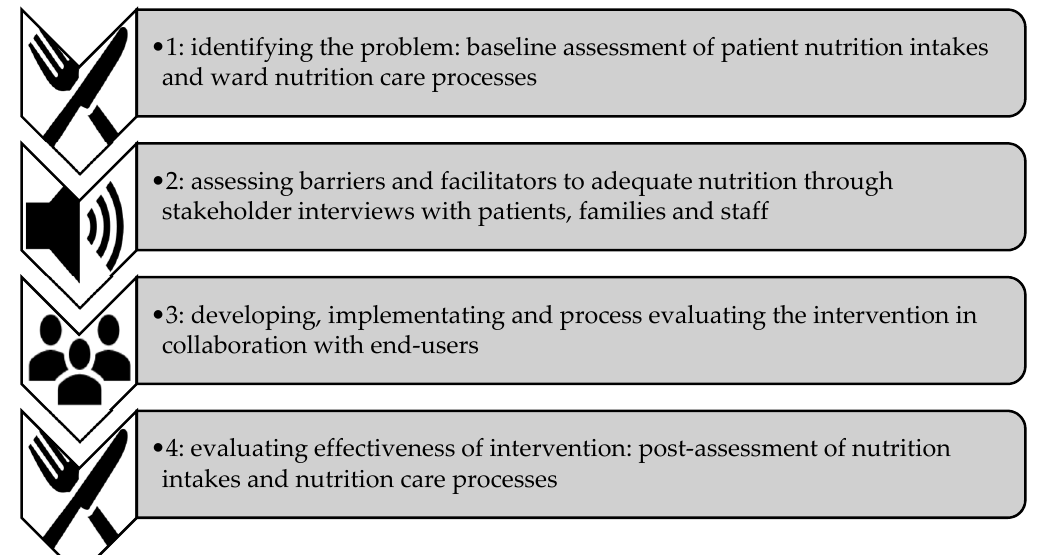
Figure 1. Four-step process used to develop, implement and evaluate the intervention.